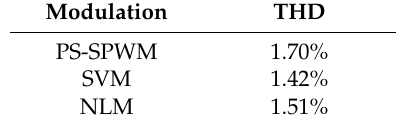
Table 4. THD output current.